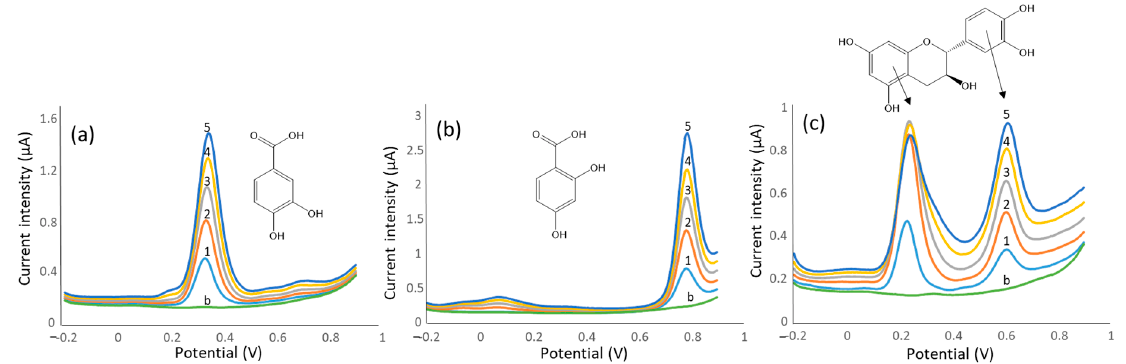
Figure 3. Differential pulse voltammograms recorded in the range from − 0.2 to + 0.9 V vs. an Ag|AgCl|KCl reference electrode for three representative examples: ( a ) 3,4-dihydroxybenzoic acid; ( b ) 2,4-dihydroxybenzoic acid; ( c ) catechin (adapted from reference [48]).